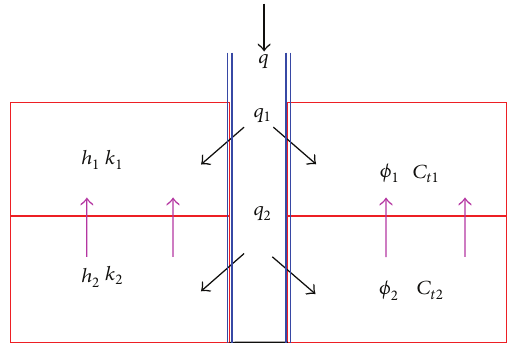
Figure 2: Sketch of polymer flooding in crossflow double-layer